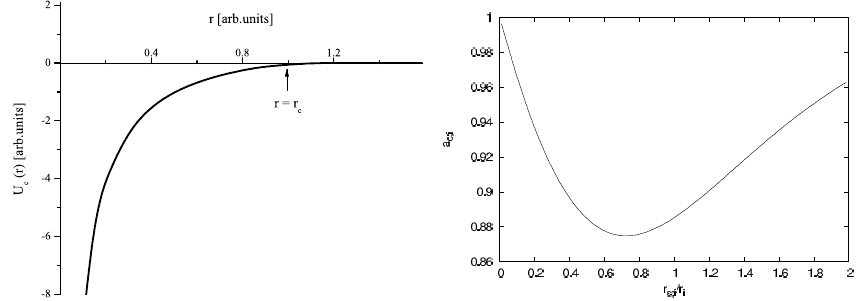
Fig. 1. Cut-off potential U c ( r ), where r c is cut-off parameter.